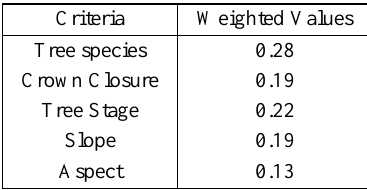
Table 2. The weighted values of criteria.